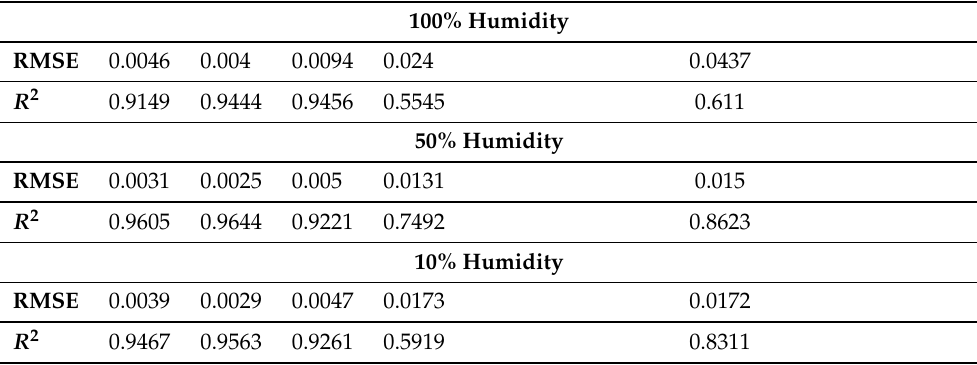
Table 2. Results of SVMR.